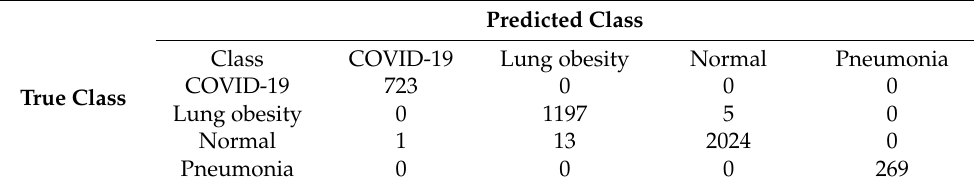
Table 5. Confusion matrix attained by ShuffleNet in four-class classification using chest radiographs.